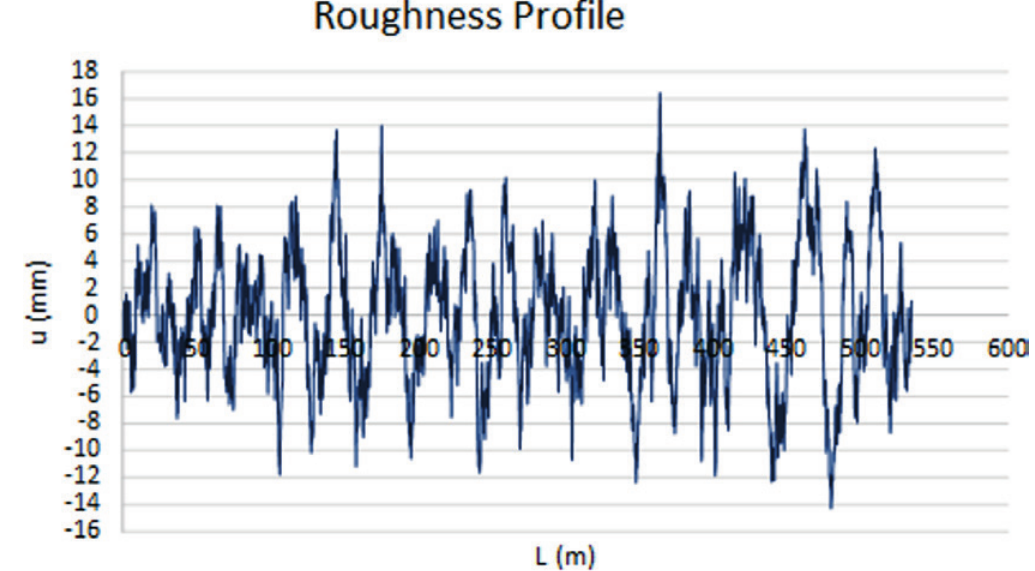
Figure 5 Roughness profile for IRI=4,10m/km, α =1,5x10-6, β =1,85 e 0,5m< λ